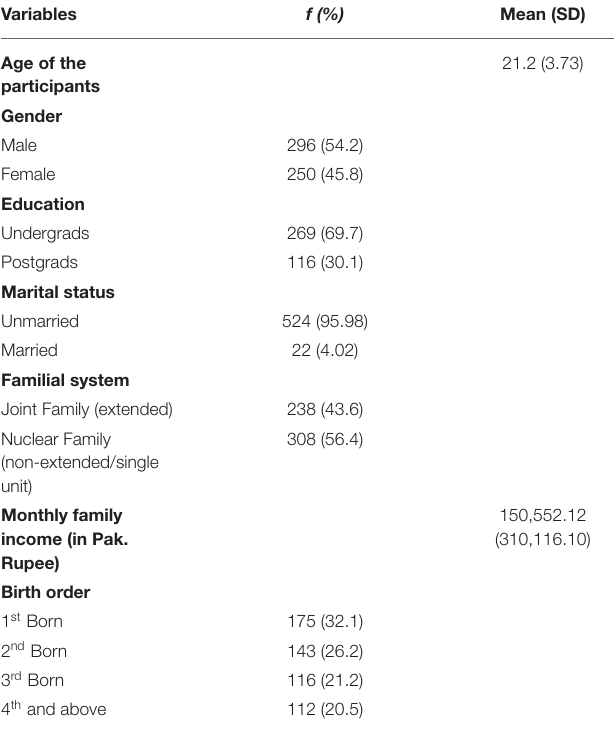
TABLE 1 | Demographic